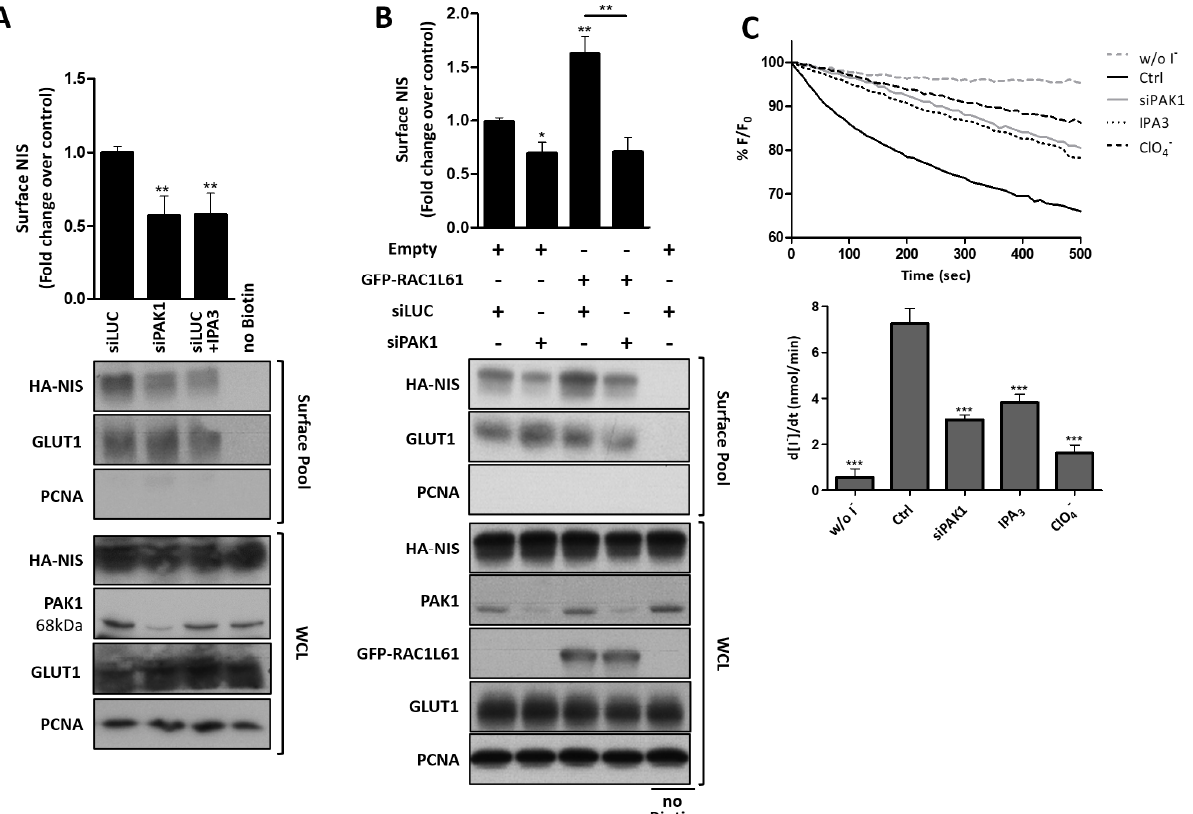
Figure 7. PAK1 participates in the RAC1-stimulated upregulation of NIS PM residency. HA-NIS-TPC1 cells were ( A ) transfected with either mock (siLUC control) or a specific siRNA against PAK1 (siPAK1), or were treated or not with PAK1 chemical inhibitor IPA3 (10 µM for 1 h); or ( B ) transfected with either empty vector (Empty) or GFP-RAC1-L61, and either mock (siLUC control) or the siPAK1, as indicated, and were analyzed by surface protein biotinylation. The surface fractions and whole-cell lysates (WCL) were then analyzed by WB, as indicated. The ‘no Biotin’ condition, which corresponds to cells which were not incubated with biotin, was used to control the specificity of biotinylated protein pull-downs. PCNA expression served both as the loading (WCL) and intracellular protein contamination control (Surface pool). GLUT-1 served as the positive loading control for the cell-surface protein extracts. The WB bands were quantified by densitometric analysis using ImageJ software. The plotted values correspond to the means ± SEM of at least three independent assays. One-way ANOVA analysis detected significant differences between the treatments [F = 9.31 and p = 0.0012 for ( A ); F = 12.73 and p < 0.001 for ( B )]. Post-hoc Tukey’s tests were used to identify significant variations relative to the control conditions or among the different treatments (the latter are indicated by horizontal lines) (* p ≤ 0.05; ** p ≤ 0.01). ( C ) Representative traces of the iodide-induced YFP fluorescence decay of HA-NIS/HS-YFP-TPC1 cells treated as in (A), or treated with 50 mM ClO 4 − for 10 min, continuously recorded as described in the legend to Figure 1. The data are the means ± SEM of five independent assays. The significant variations were assessed by one-way ANOVA (F = 30.50; p < 0.001) followed by Dunnett’s post- hoc test, as compared with the control conditions (Ctrl) (*** p < 0.001).